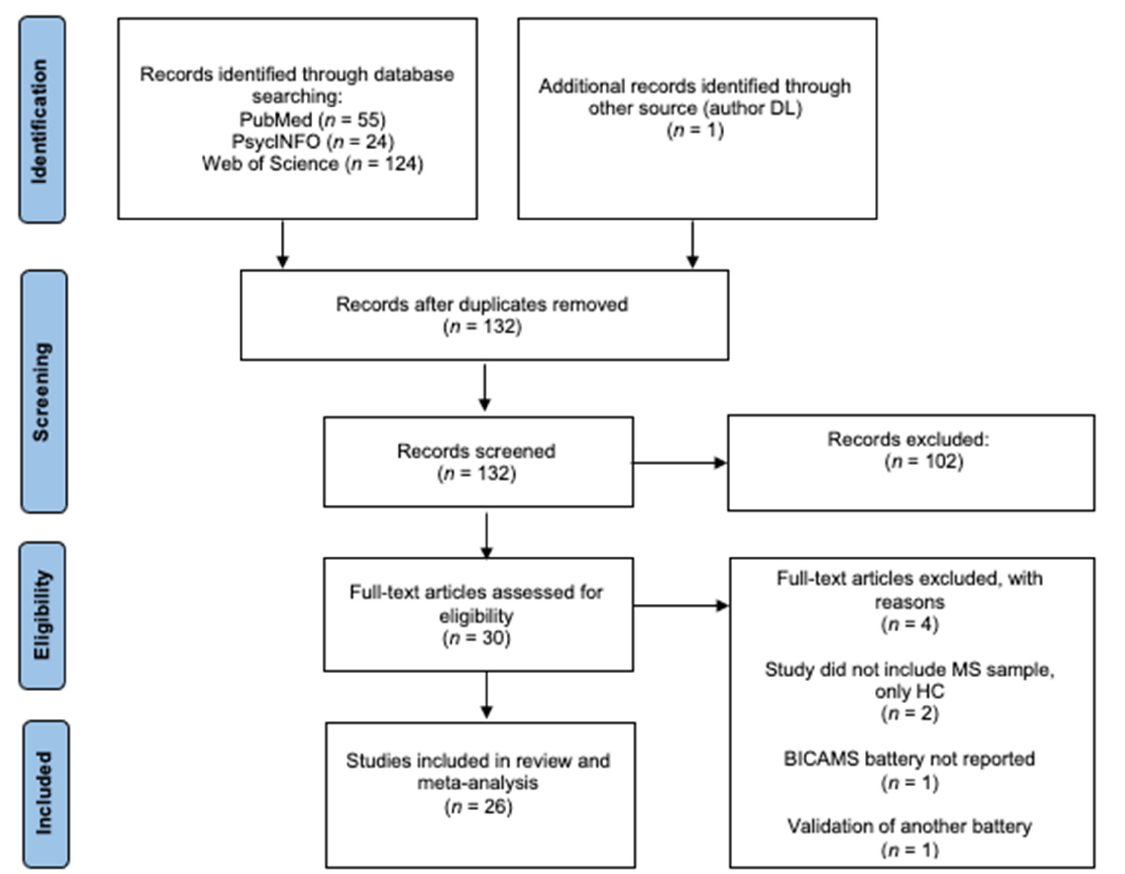
Figure 1. PRISMA flowchart for selection process of studies in systematic review and meta-analysis.